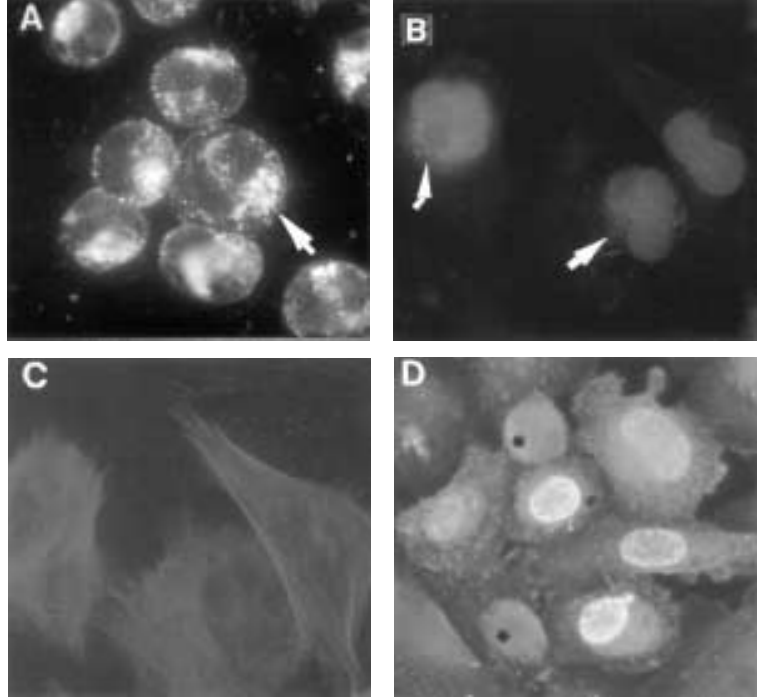
Fig. 1. A, Immunofluorescence staining of CEM cells with the anti TK1 antibody (arrows); B, Triple fluorescence stained Hela cells: TK1 (FITC, green, arrows), cellular filament (Rhodamine, red) and DNA (DAPI, blue); C, Cytoskeleton (Rhodamine, red) in same cells as in Fig. 1B; D, Double immunofluorescence stained PC-3 cells: TK1 (Rhodamine, red), anti BrdU (FITC, green), TK1 positive cells and BrdU negative ( * ) presuming late G1 cells.